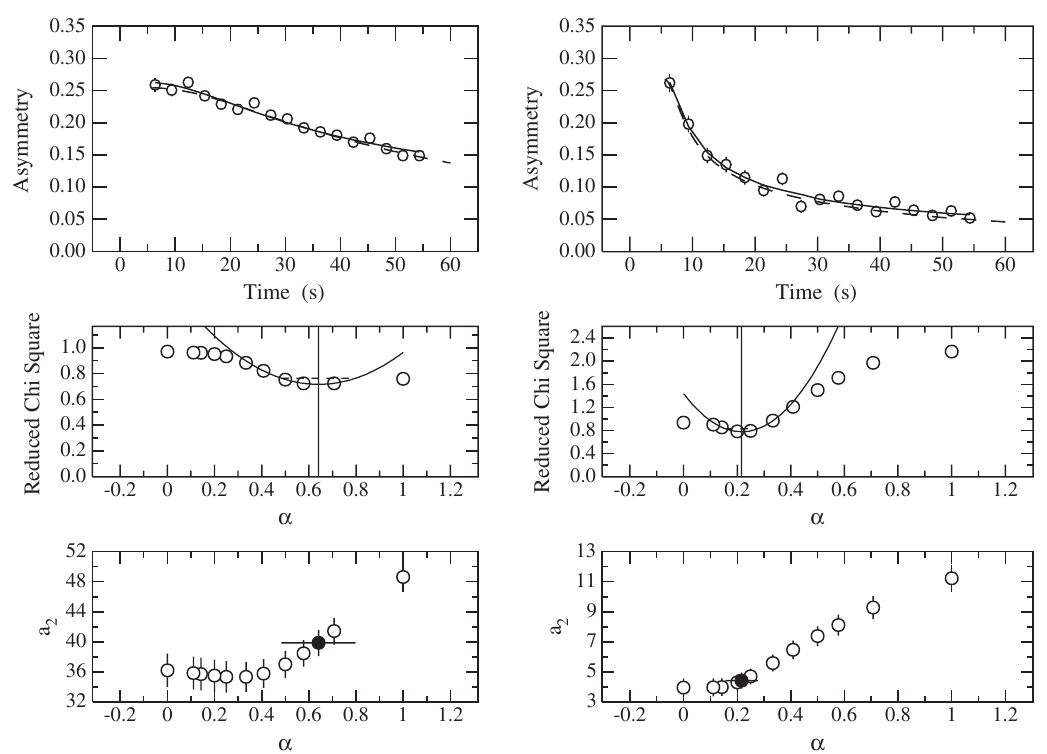
FIG. 14. Two different analysis cases are shown for a long polarization lifetime on the left and a short polarization lifetime on the right. The top panel shows the data and the fits with the same legend for the curves as described in Fig. 13. For the purpose of illustration, the template and bias-corrected curves (as in Fig. 13) with the value of α closest to the best fit values are shown. In the second panel is a series of reduced chi square values for each of the templates spanning a series of α values between 0 and 1. In both cases there is a minimum that indicates the best choice of α . This is located more precisely by reproducing the local shape of the reduced chi square distribution with a parabola as shown. The vertical line indicates the value for α where the parabola has a minimum. In the third panel, each fit with a specific template also generates a value with a statistical error for the a 2 parameter. The value with the filled point is an interpolation of the values of a 2 to the best value of α . The parabolic fit to the reduced chi square results may also be used to determine the error in the value of α . This is projected onto the a 2 result as the horizontal error on the black point, and indicates the uncertainty beyond statistics from the quality of the template fit. In the left-side case, this uncertainty exceeds the statistical uncertainty. Since the beam distribution is obtained by horizontal heating, the right-side panels represent a beam with a large horizontal extent, thus leading to a small value of α and a short polarization lifetime. Similarly, the left-side panels are for a more nearly round beam. Thus the values of α correspond to the known changes in the setup of the beam. For the long and short lifetime cases (left and right panels), the values of a ¼ 39 . 8 (cid:1) 4 . 1 and 4 . 41 (cid:1) 0 . 72 , leading to Gaussian-equivalent polarization lifetimes of 44 . 6 (cid:1) 4 . 5 s and 5 . 62 (cid:1) 0 . 92 s respectively 2 (see next section). The errors include statistics and quality of